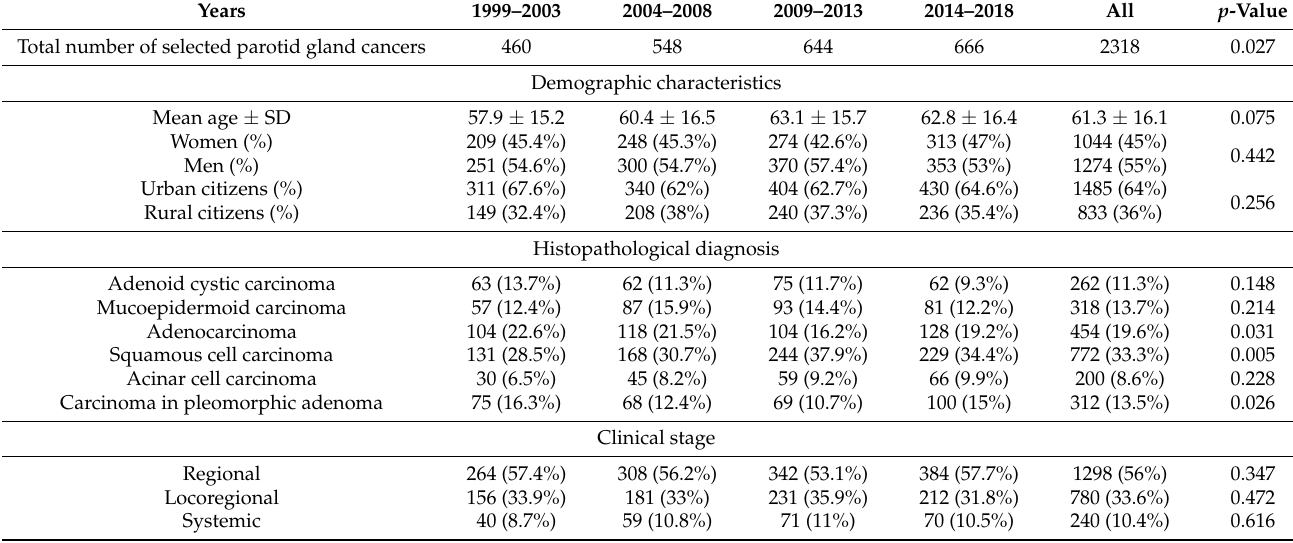
Table 1. Characteristics of patients diagnosed with parotid cancers in NCR in